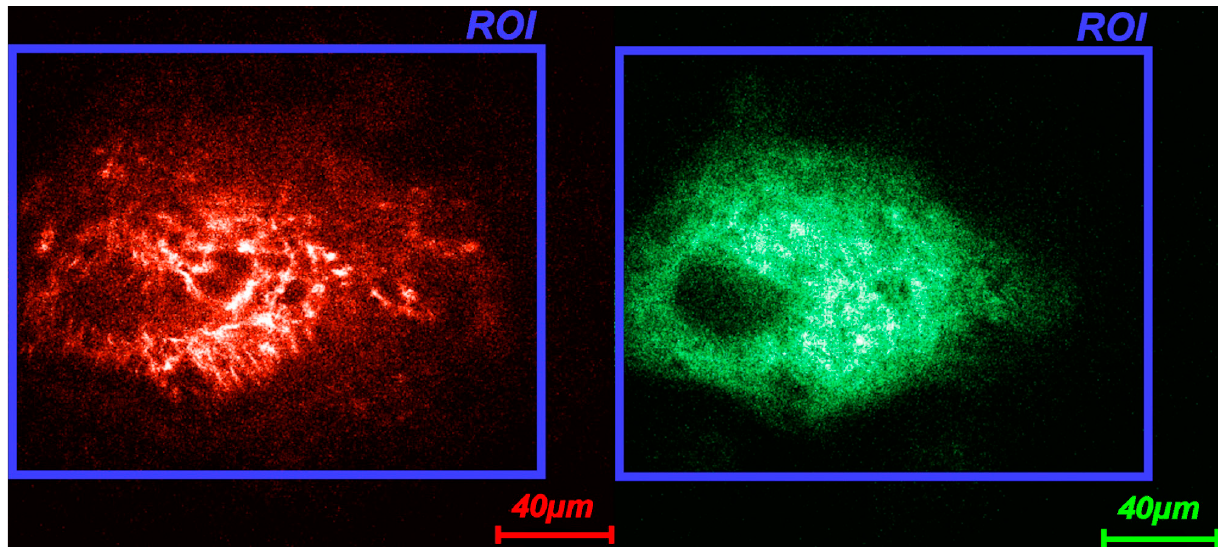
Figure 1. Definition of region of interest (ROI) for the quantification of collagen (second harmonic generation (SHG), green) and elastin (autofluorescence (AF), red)